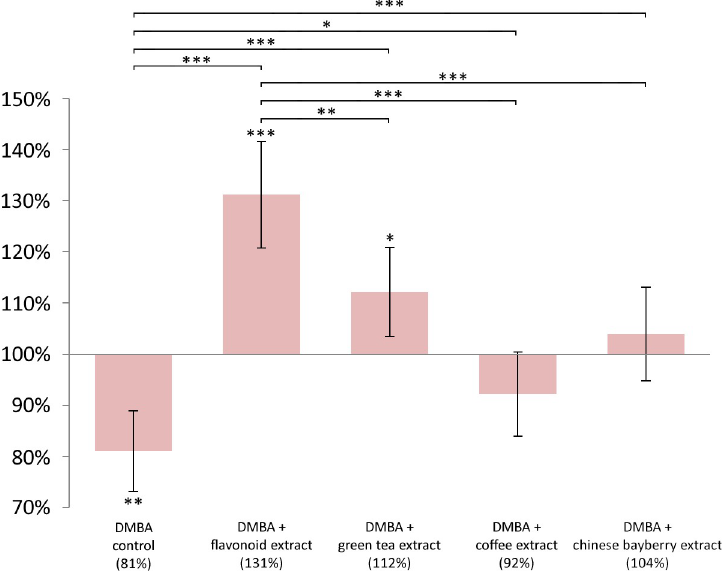
Fig 1. LINE -1 methylation pattern in the liver of mice. LINE-1 methylation pattern in the liver of CBA/Ca female mice (n = 6) due to the effect of DMBA, flavonoid extract, green tea extract, coffee extract and chinese bayberry extract, expressed as the ratio of untreated control ( � p < 0.05, �� p < 0.005, ��� p < 0.001).